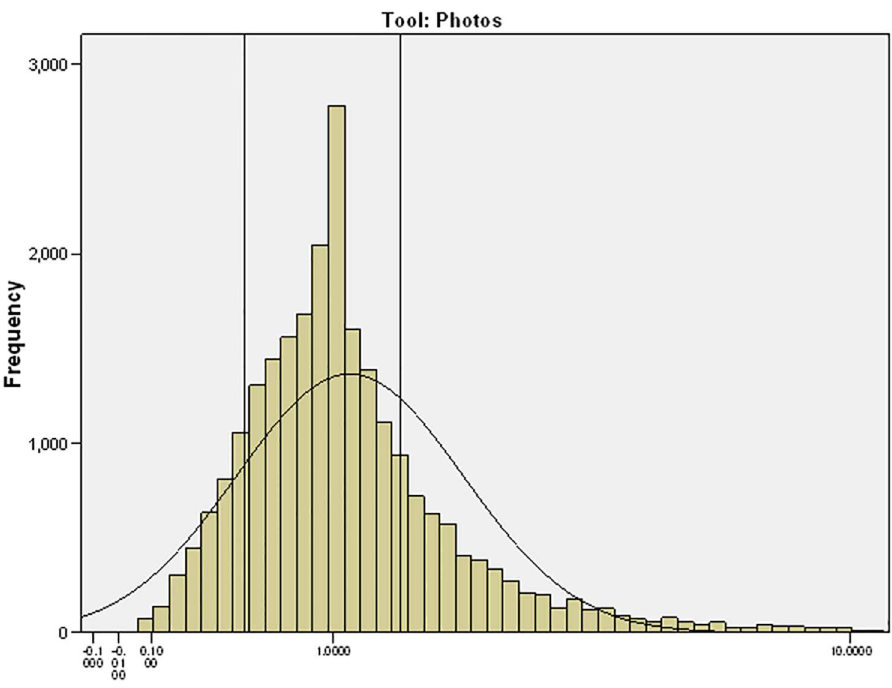
Fig 8. Histogram displaying the range in the ratio of estimated weight to actual weight for estimates made using YPFA of the amount of food consumed (50% of the total number of estimateslie between the two vertical lines on the graph).